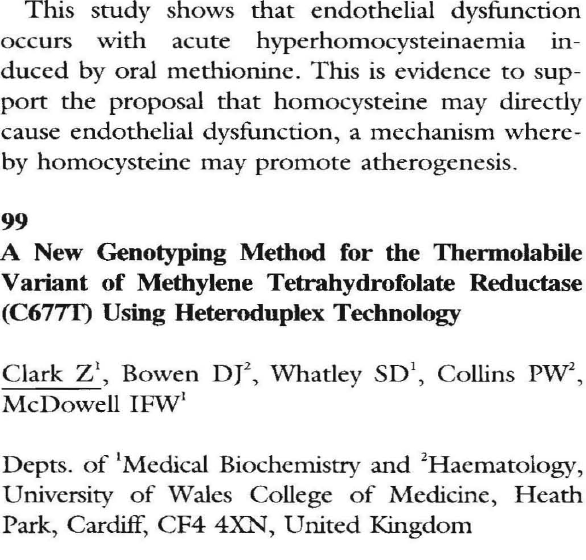
The heteroduplex technique